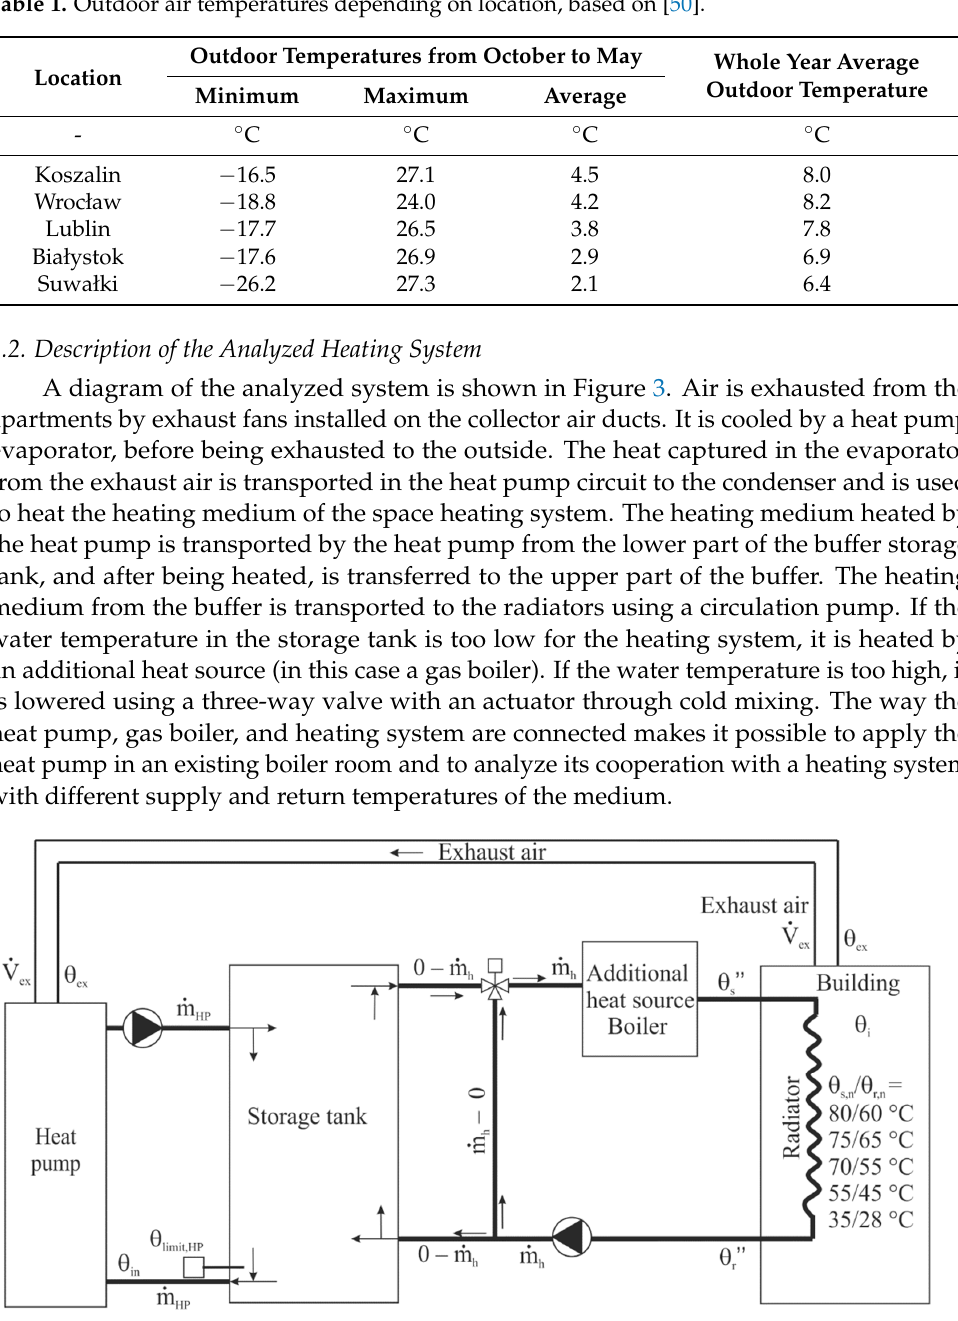
Figure 3. Diagram of the analyzed heating system.